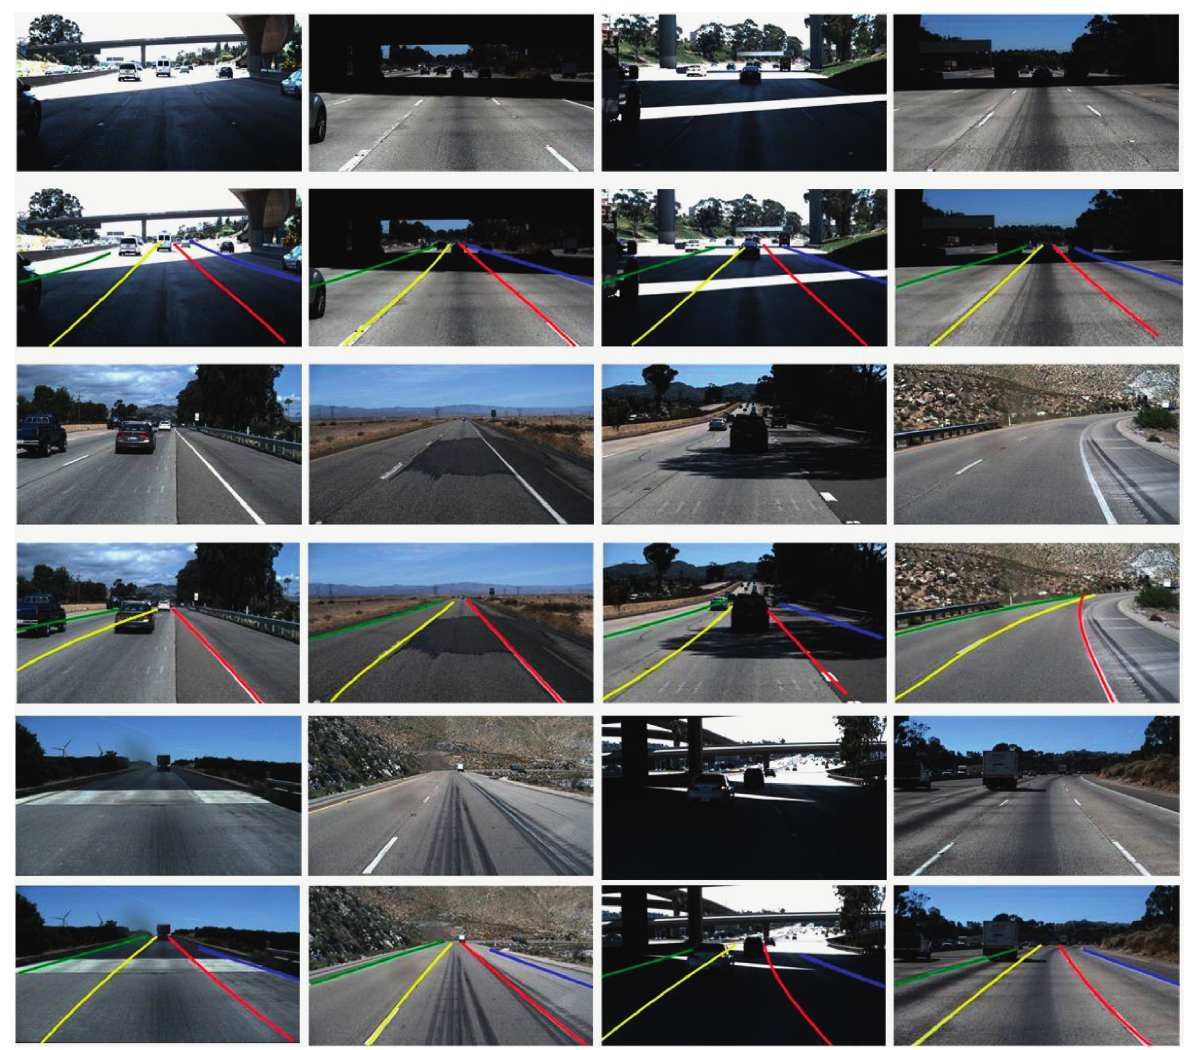
Figure 9: Robustness test for proposed method on TuSimple dataset. The odd lines display the original images, and the even lines present lane predictions overlapping on original